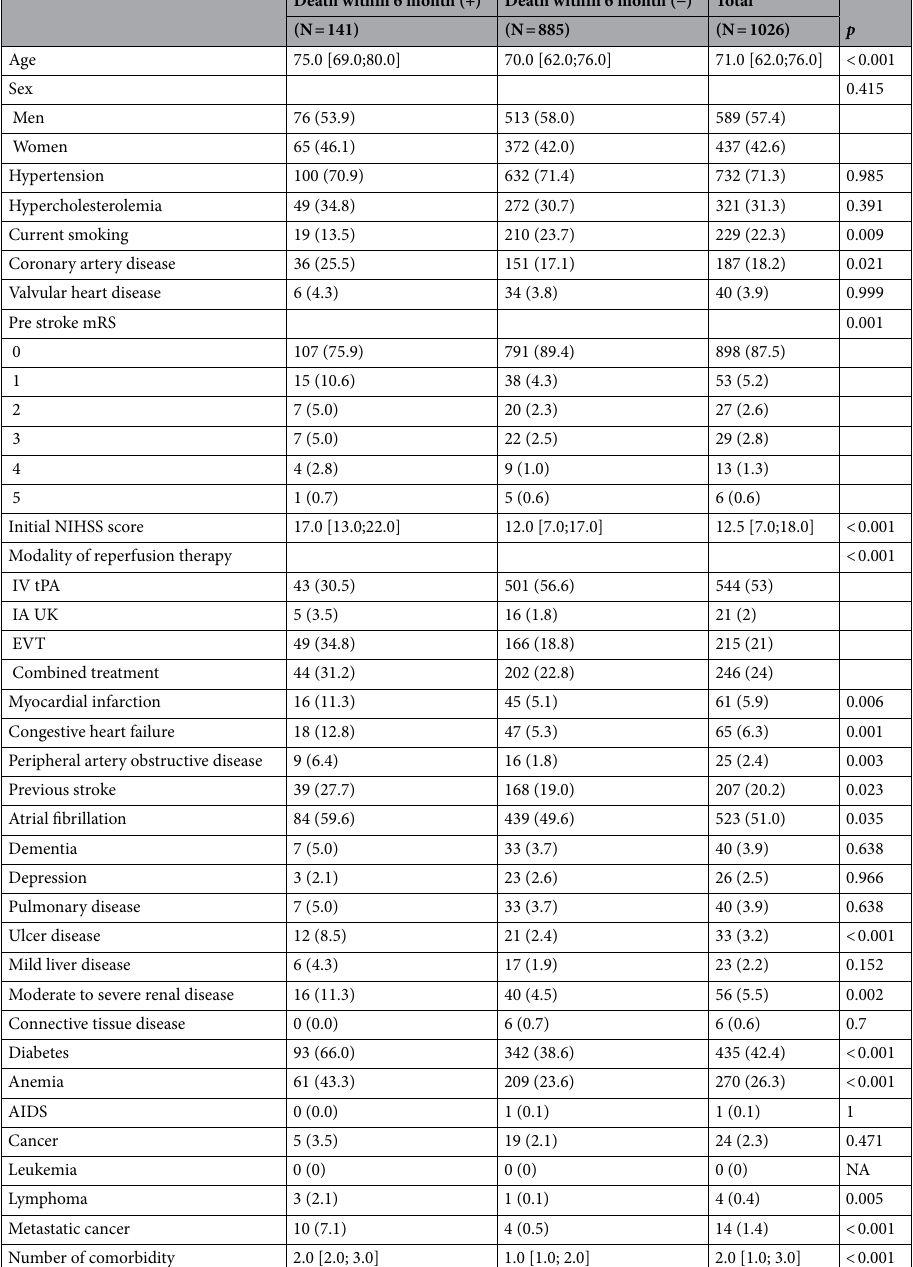
Table 1. Factors associated with mortality within 6 months. mRS, modified Rankin scale; NIHSS, National Institutes of Health Stroke Scale score; IV tPA, intravenous tissue-type plasminogen activator; IA UK, intraarterial urokinase; EVT, endovascular treatment; AIDS, Acquired Immune Deficiency